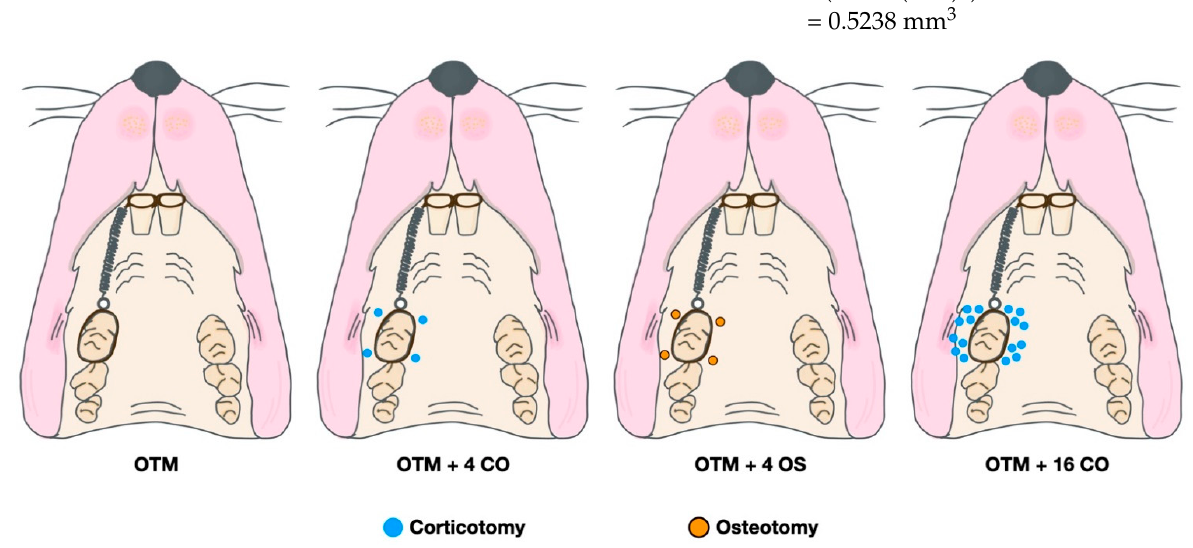
Figure 2. Diagram of surgical and orthodontic tooth movement procedures.